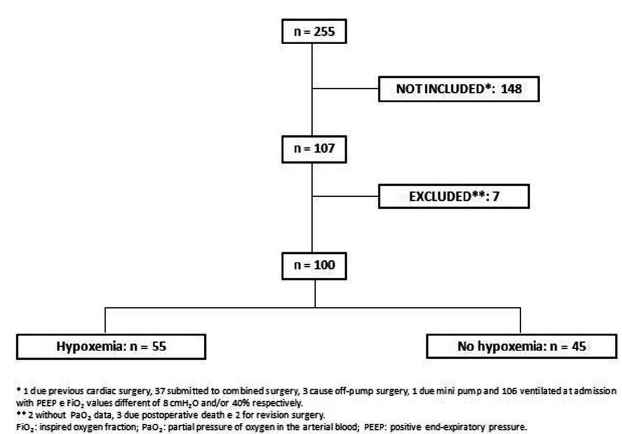
Fig 1 - Patients admitted to the Cardiovascular Intensive Care Unit after coronary artery bypass graft